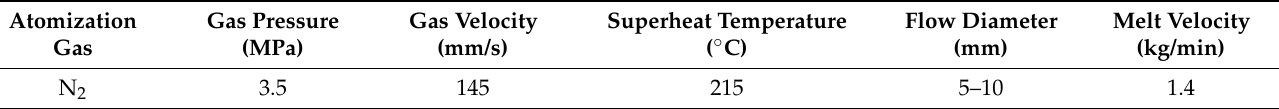
Table 1. Vacuum atomization parameters for fabricating Cu-Zr-Al-Ag-Co amorphous alloy powders.